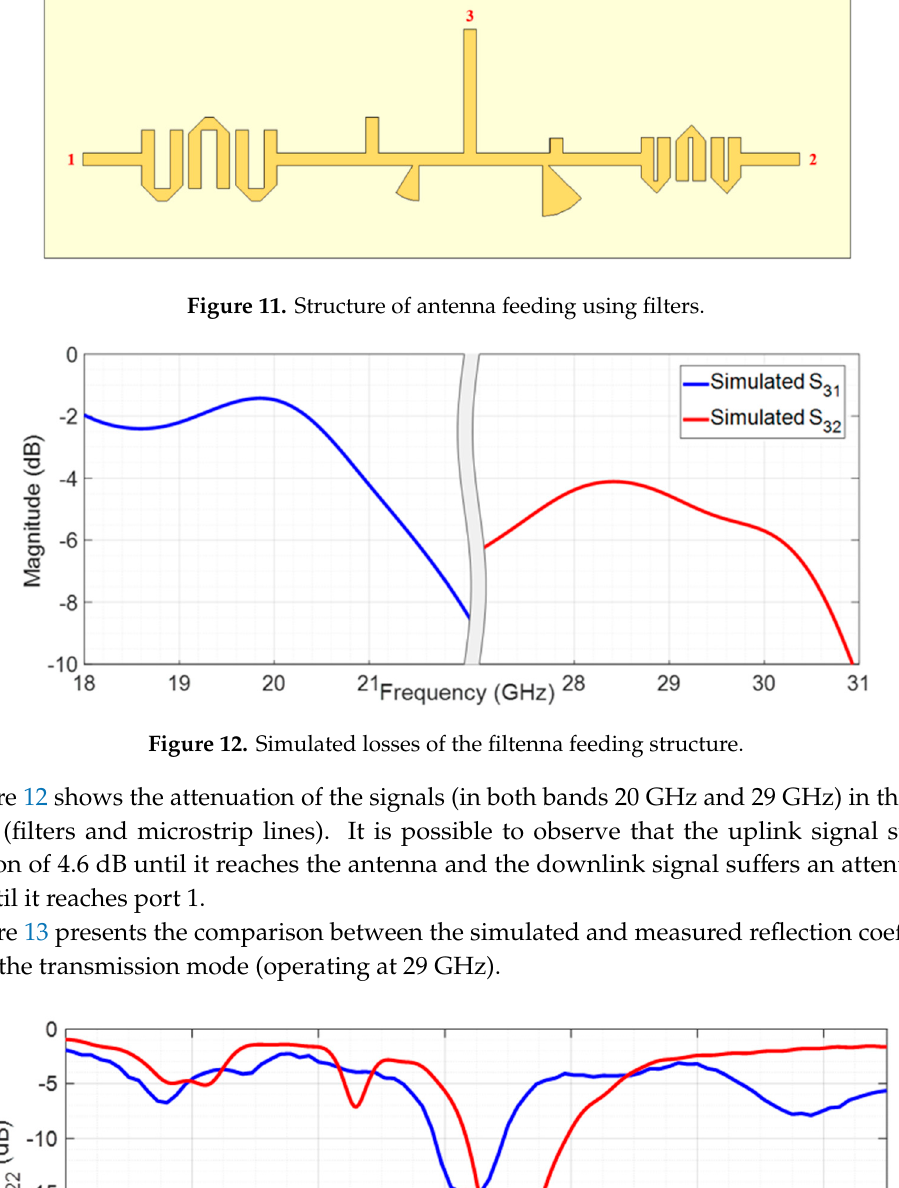
Figure 13. Simulated and measured reflection coefficient of the filtenna in transmission mode.